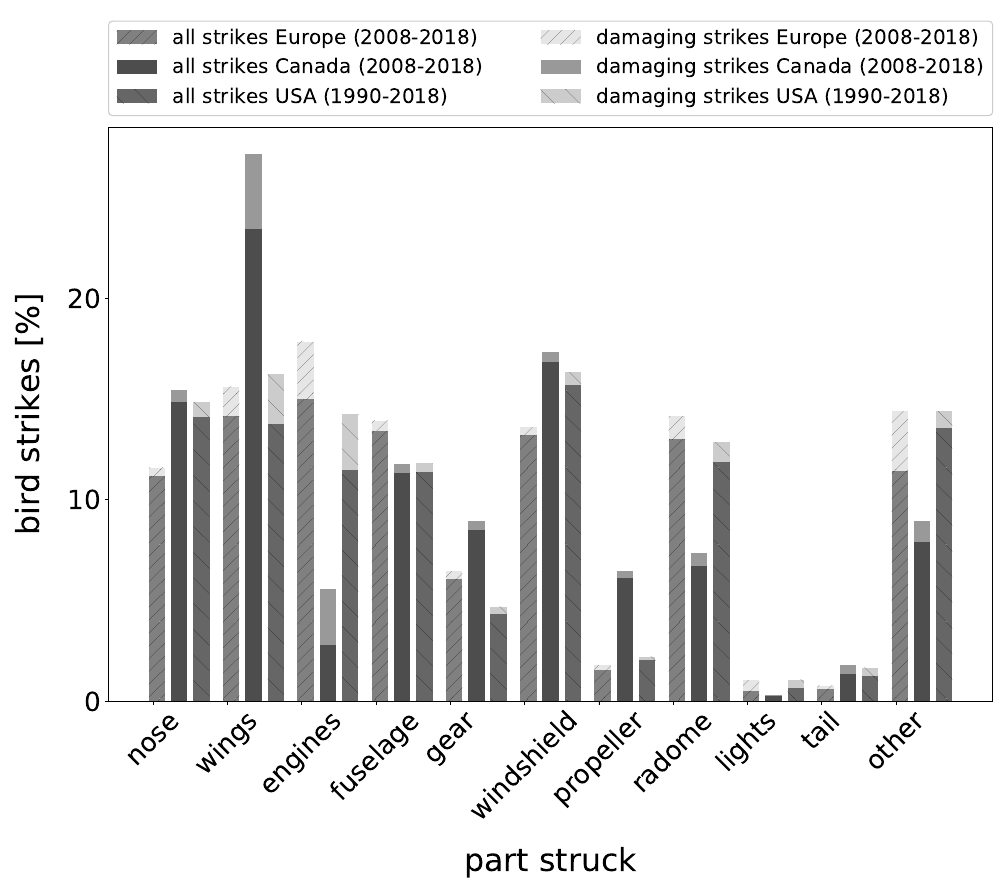
Figure 4. Total number of bird strikes per part indicating number of damaging strikes for Europe, Canada and the USA